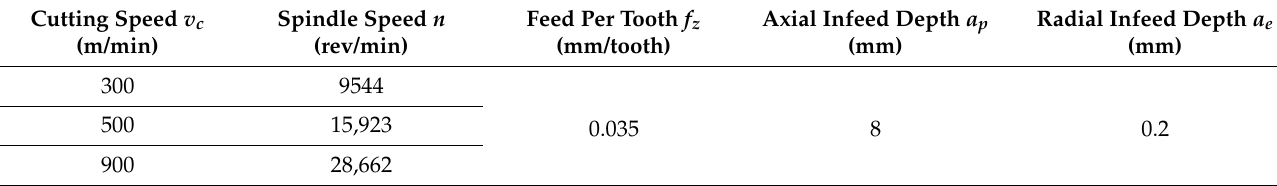
Table 3. Parameters of research